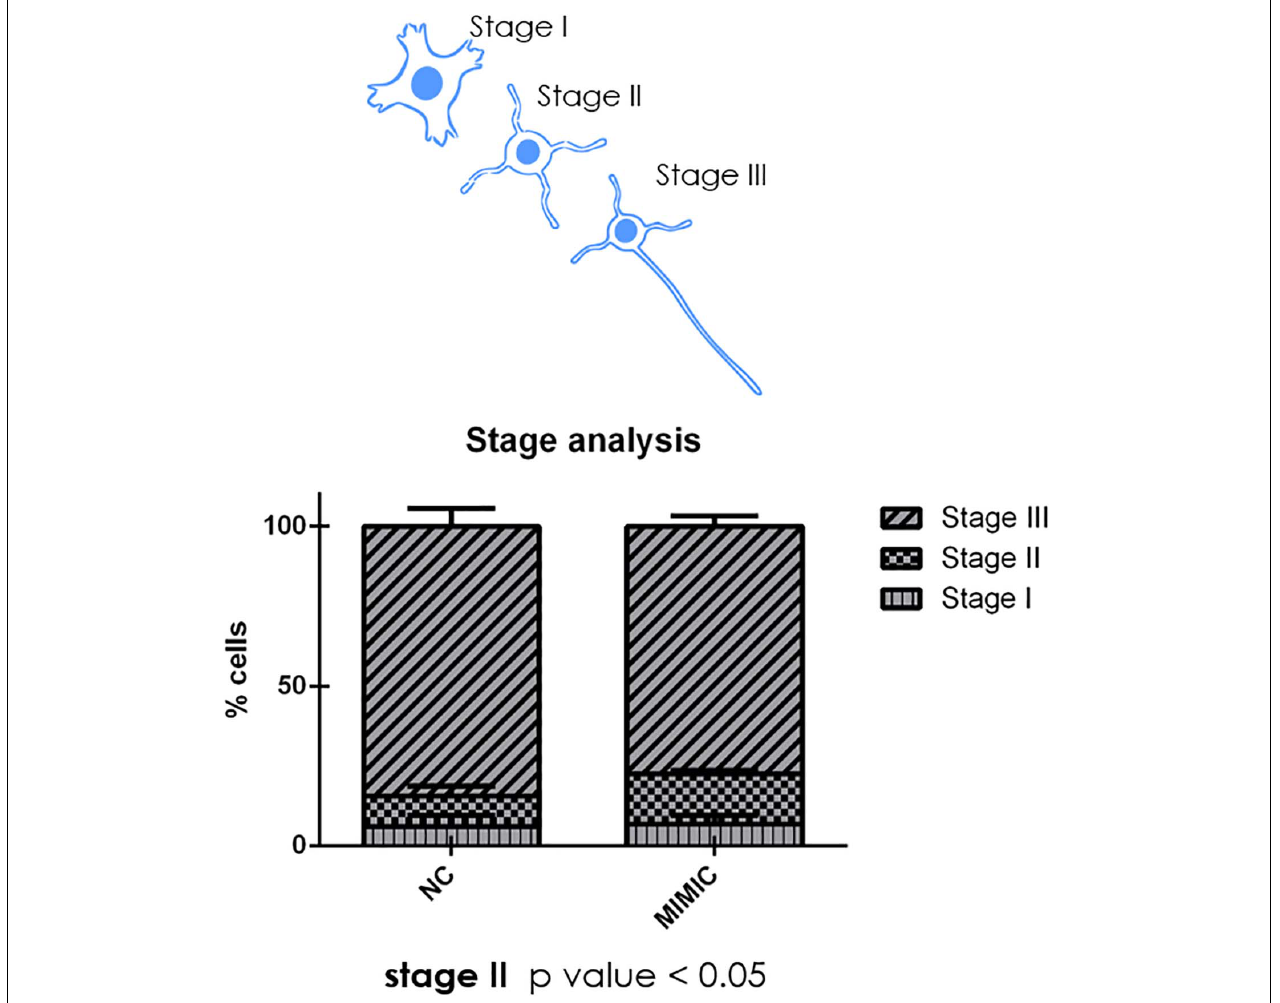
FIGURE 8 | moiR-7b-3p increases the number of neurons in stage II. The number of stage I, II, and III neurons is expressed as a percentage on the total number of neurons analysed. An increased stage II number of neurons is shown ( n = 4; t -test * p ≤ 0.05 for stage